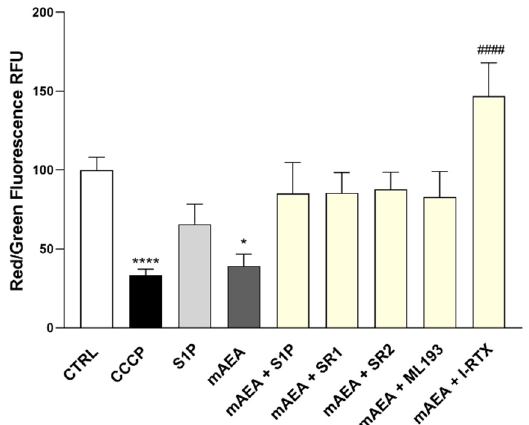
Figure 6. The polarization state of the mitochondrial membrane was assessed after the cells were exposed to mAEA (10 μ M), and mAEA + S1P (1 μ M) and in the presence of selective antagonists to eCB-binding receptors (SR1, SR2, ML193 and I-RTX) for 24 h. Values are expressed as ratio of red (~590 nm) / green (~529 nm) fluorescent intensity. Ratio are presented as mean ± SEM of three independent experiments ( n = 3). Statistical analysis was performed by ONE-WAY ANOVA followed by Bonferroni post-hoc test [* p < 0.05, **** p < 0.0001 vs. control cells (CTRL); #### p < 0.0001 vs. mAEA]. Since 10 µ M mAEA markedly depolarized the mitochondrial membrane, we checked a dose-dependent cytotoxicity, and at 10 µ M, it significantly reduced cell viability by 30 ± 3.0% (Figure 7).